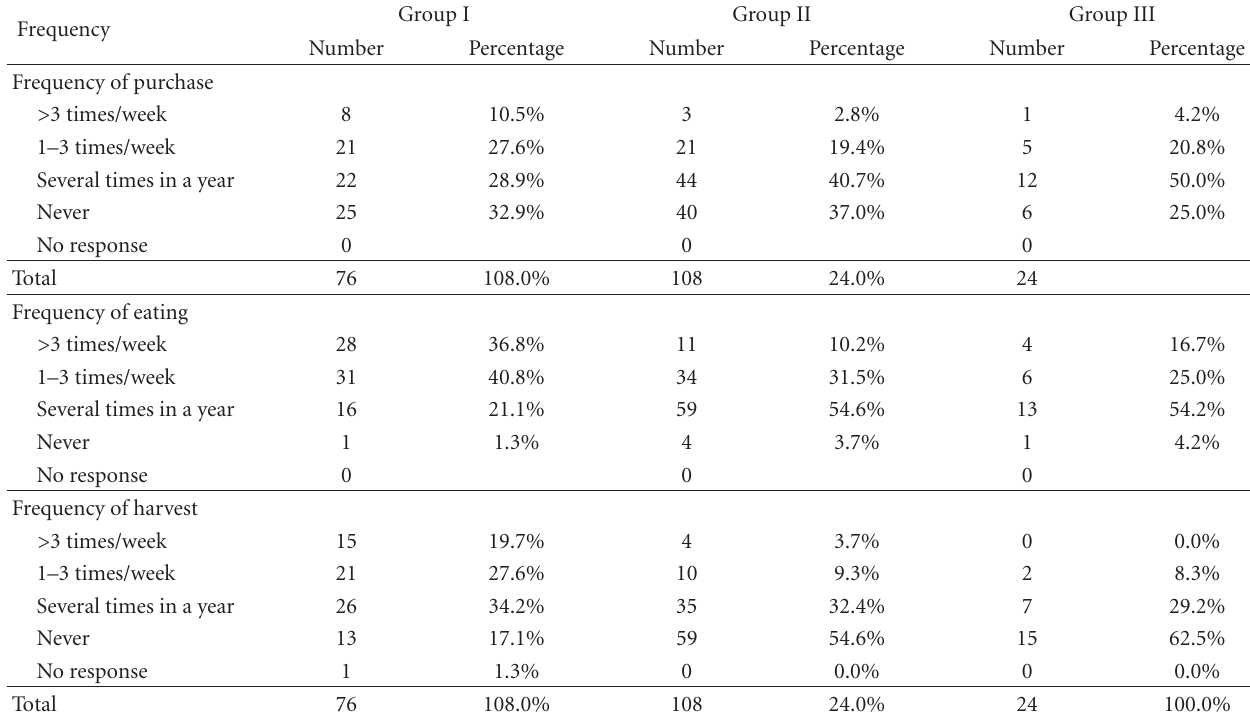
Table 4: Frequency of purchase, eating, and harvest edible wild